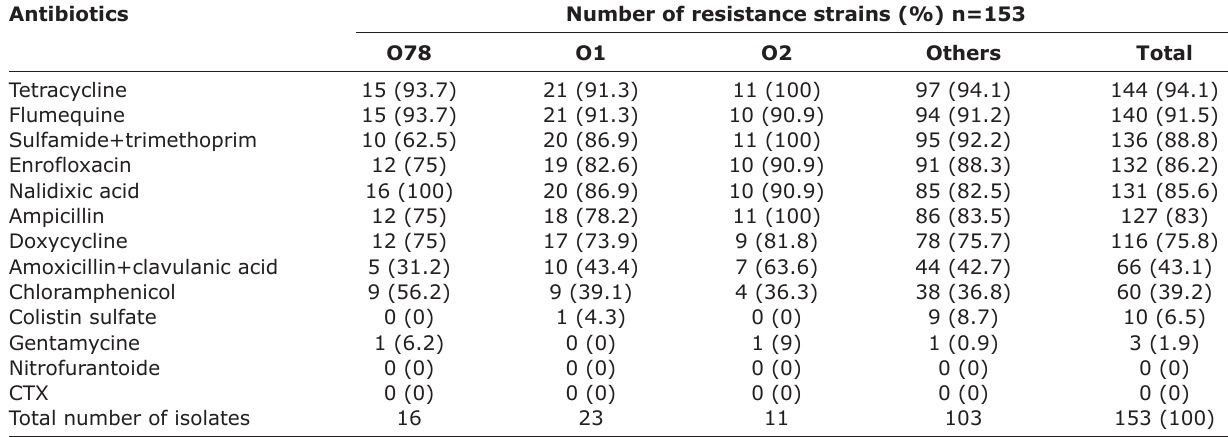
Table-1: Antibiotic resistance and serogroups of 153 Escherichia coli strains isolated.